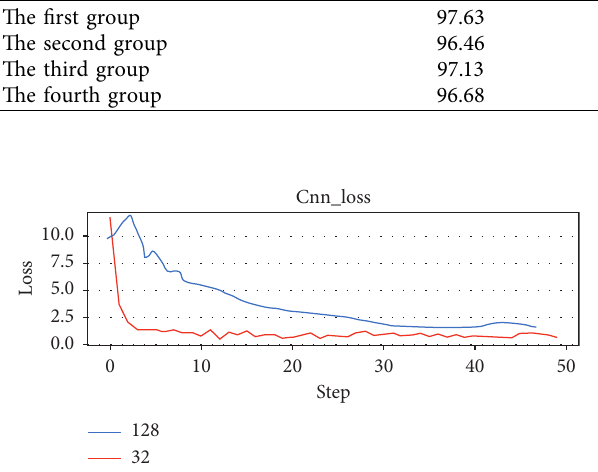
Figure 9: Comparison of loss value function curves of different